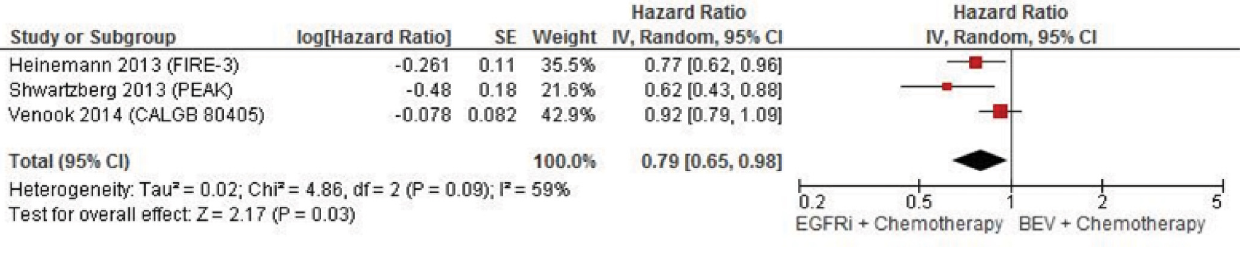
Fig 4. Forest plots of hazard ratios comparing overall survival of EGFRis with chemotherapy versus BEV with chemotherapy.